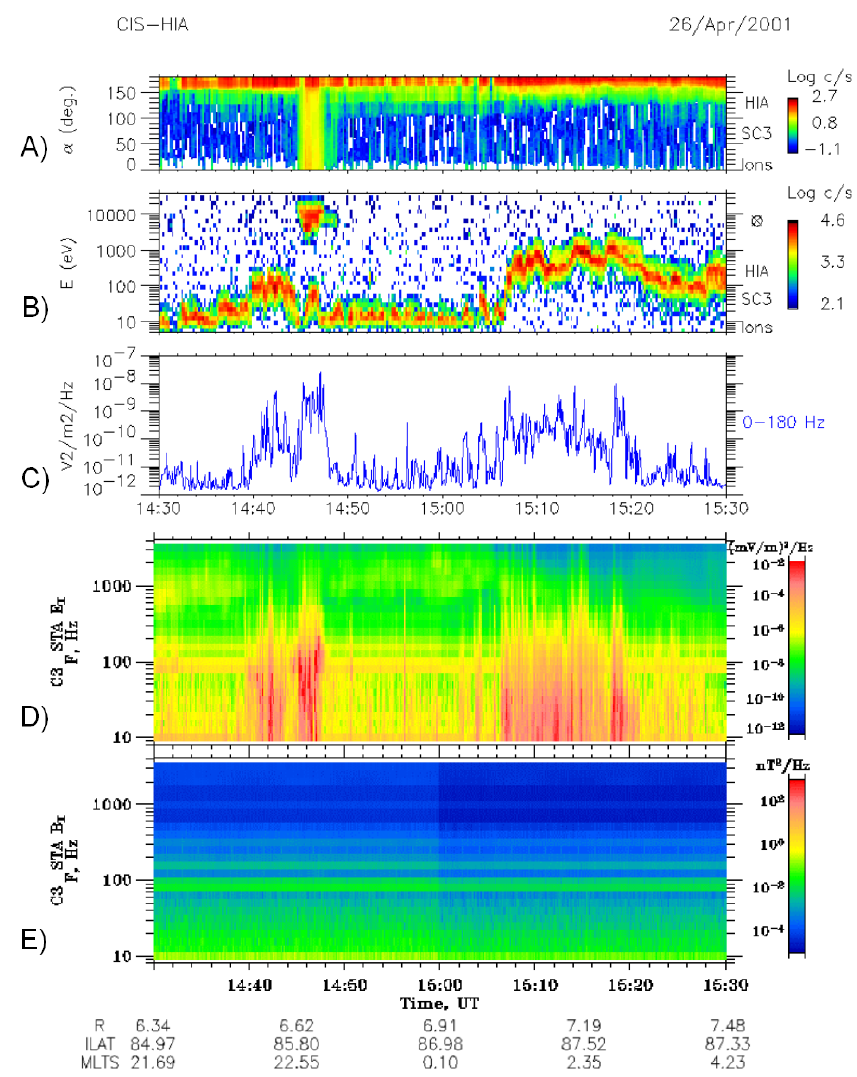
Fig. 15. 26 April 2001. From top to bottom: (A) Ion pitch-angle distribution from HIA for all ions. (B) Energy-time spectrogram from HIA for all ions. (C) Electric field spectral density from 0 to 180Hz from the STAFF instrument. (D) Frequency-time spectrogram for electric field waves from STAFF in the frequency range from 10 to 3000Hz. (E) Frequency-time spectrogram for magnetic field waves from STAFF in the frequency range from 10 to